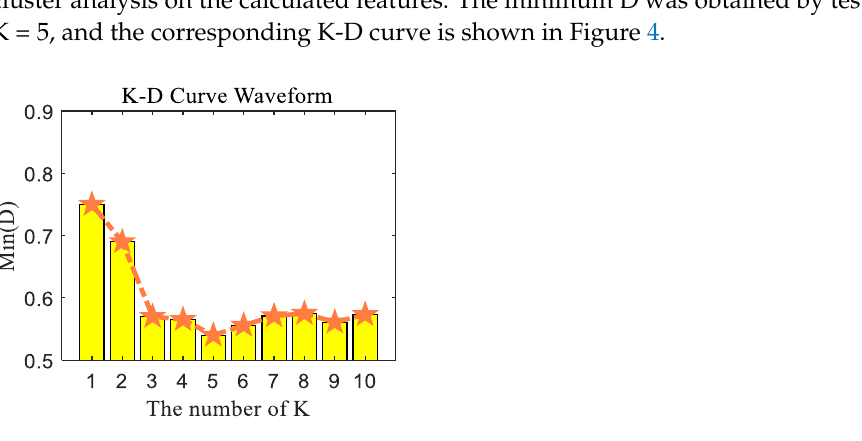
( b ) Figure 5. The load curve in February ( a ) clustered 5 types of loads; ( b ) the type 3 load.